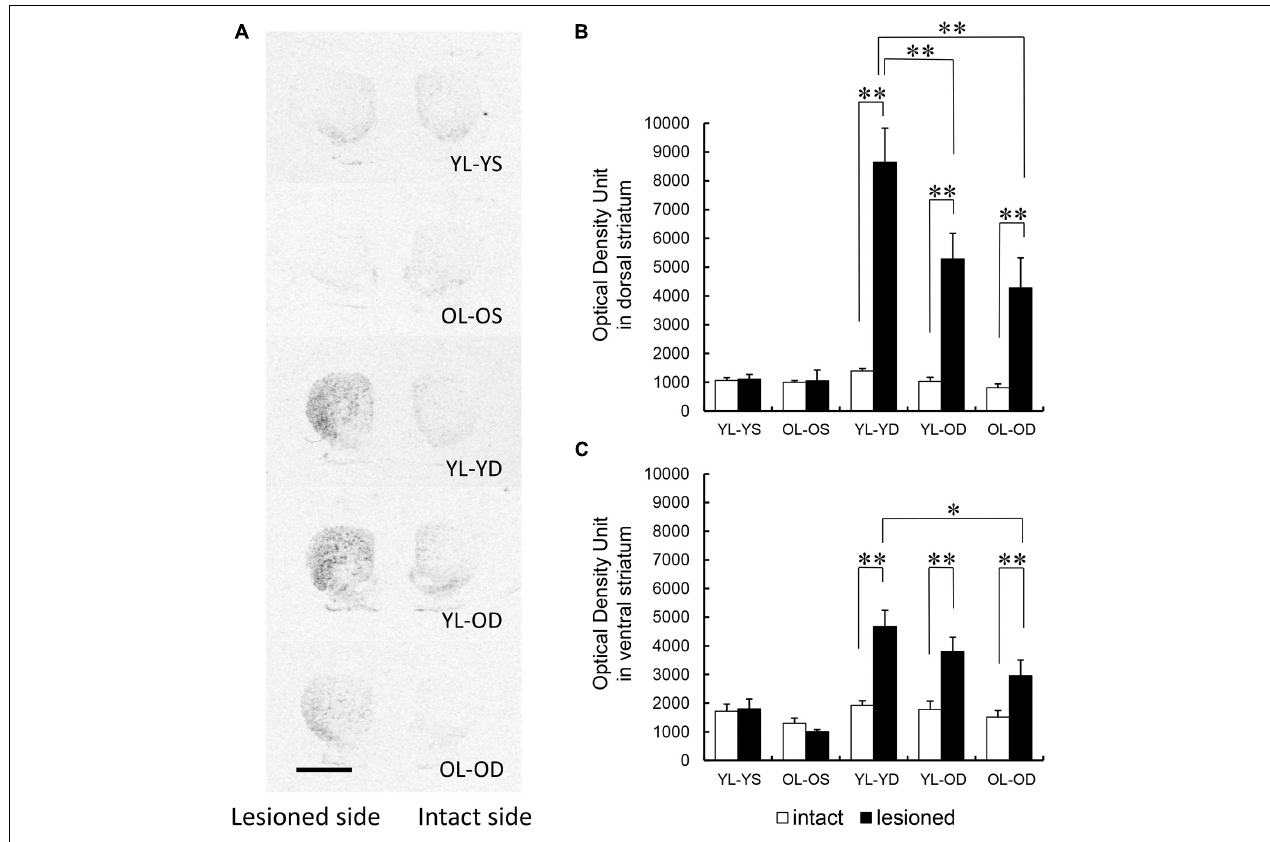
FIGURE 3 | Regional distribution of striatal preprodynorphin mRNA expression in five experimental groups. (A) Representative autoradiograph images of the rat striatum from the five experimental groups. Dark areas correspond to regions rich in hybridization signals. Scale bar, 3 mm. (B) Preprodynorphin mRNA expression in the dorsal striatum of lesioned side was increased in the YL-YD, YL-OD, and OL-OD groups compared with that on the intact side. The expression in the lesioned side of the YL-YD group was significantly higher than that in the YL-OD and OL-OD groups. There was no significant difference between the YL-OD and OL-OD groups. There were significant differences for YL-YS versus YL-YD, YL-YS versus YL-OD, YL-YS versus OL-OD, OL-OS versus YL-YD, OL-OS versus YL-OD, and OL-OS versus OL-OD groups on the lesioned side (not indicated in the figure). (C) Preprodynorphin mRNA expression in the ventral striatum of lesioned side was increased in the YL-YD, YL-OD, and OL-OD groups compared with that on the intact side. The expression in the lesioned side of the YL-YD group was significantly higher than that of the OL-OD group. The expression levels in the YL-OD group were not significantly different from those in the YL-YD or OL-OD groups. There were significant differences for YL-YS versus YL-YD, YL-YS versus YL-OD, OL-OS versus YL-YD, OL-OS versus YL-OD, and OL-OS versus OL-OD groups on the lesioned side (not indicated in the figure). * p < 0.05; ** p < 0.01. Error bars represent the standard error of the mean. L -dopa, levo-dihydroxyphenylalanine; OL-OD, old-lesioned old- L -dopa group; OL-OS, old-lesioned old-saline group; YL-OD, young-lesioned old- L -dopa group; YL-YD, young-lesioned young- L -dopa group; YL-YS, young-lesioned young-saline